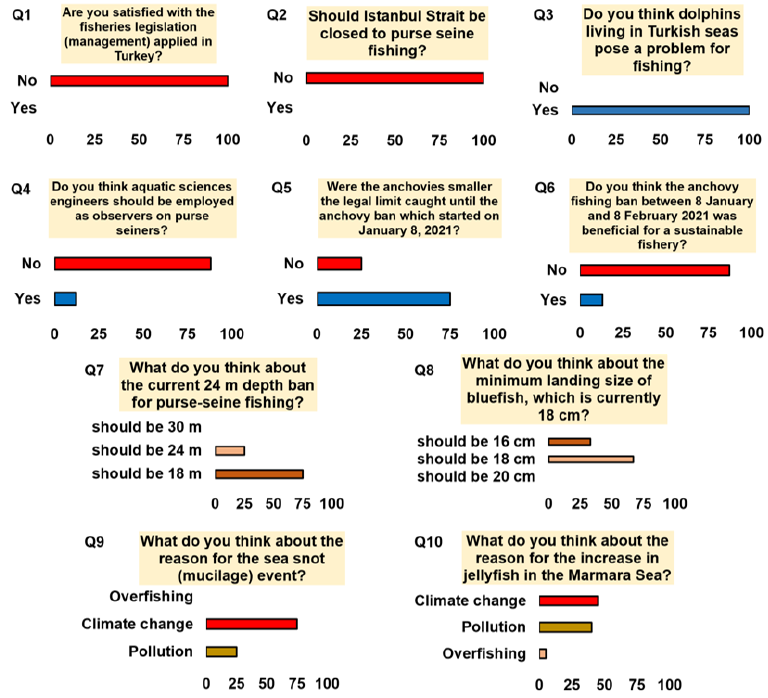
Figure 5. General results of the ten survey questions with % of respondents on X-axis.